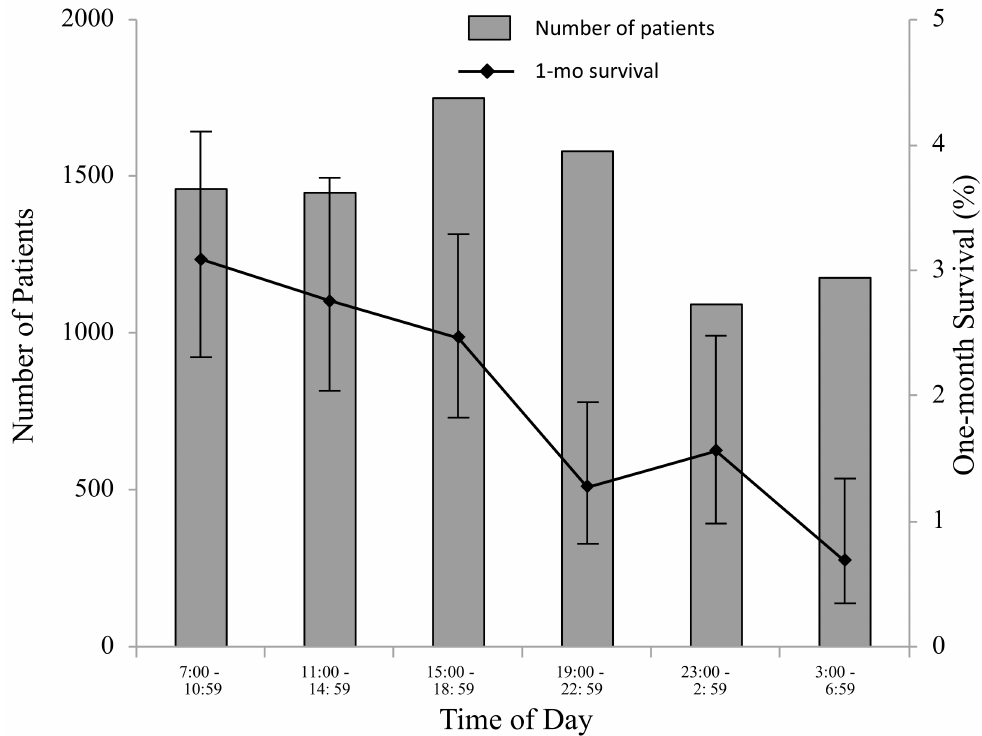
Figure 2. Number of patients and rate of one-month survival by time of day. Time of day was categorized into six periods according to 4-h intervals. One-month survival was highest during 7:00 a.m. to 10:59 a.m. and lowest during 3:00 a.m. to 6:59 a.m. ( p <